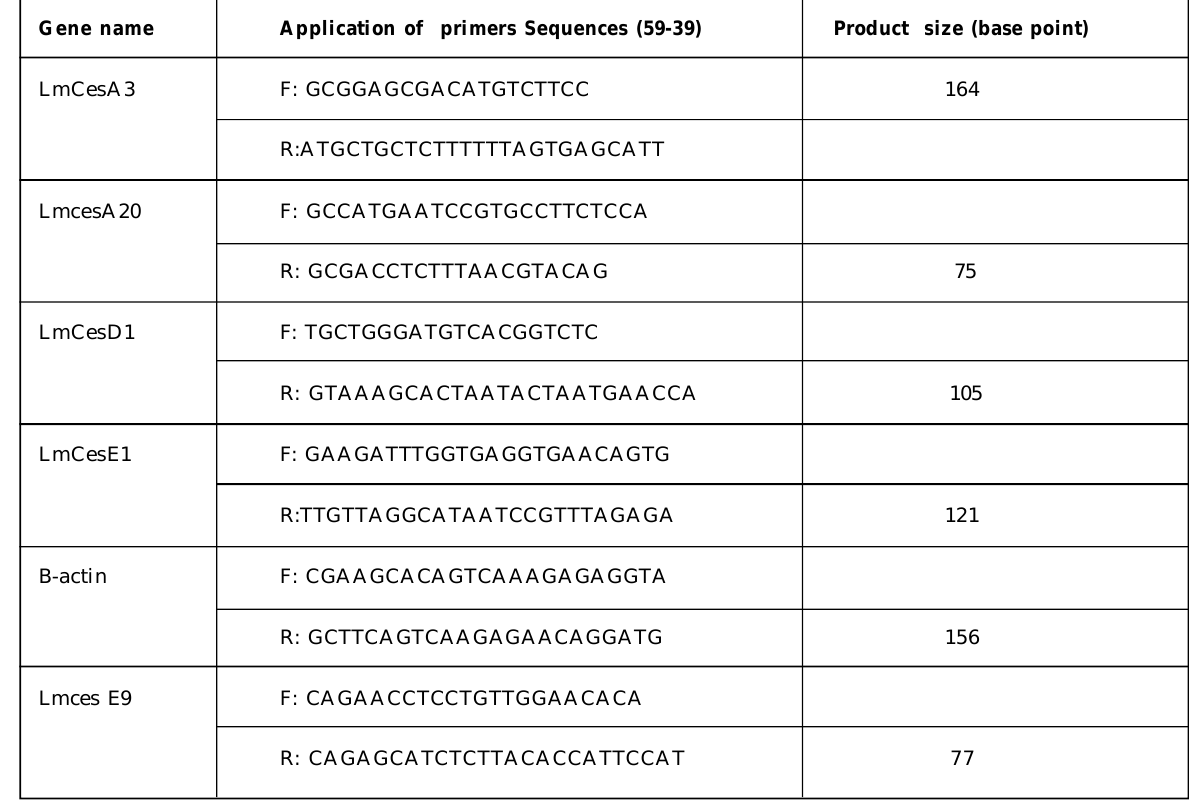
Table 1: Table of primer selected to test for Carboxylesterase gene in Z. variegatus Gene